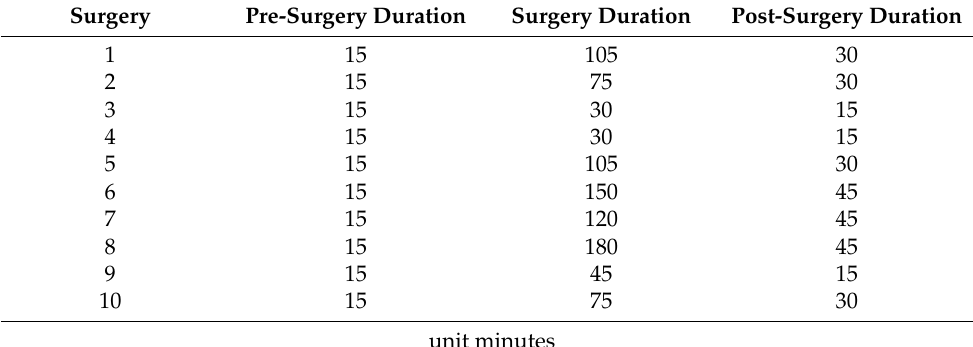
Table 2. Data of